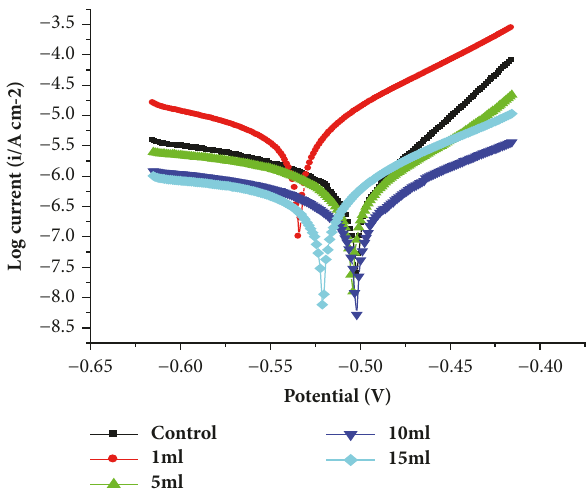
Figure 5: Variation of potential (E) against log current (A) for different volumes of oil extract and cathodic protection of steel with zinc in